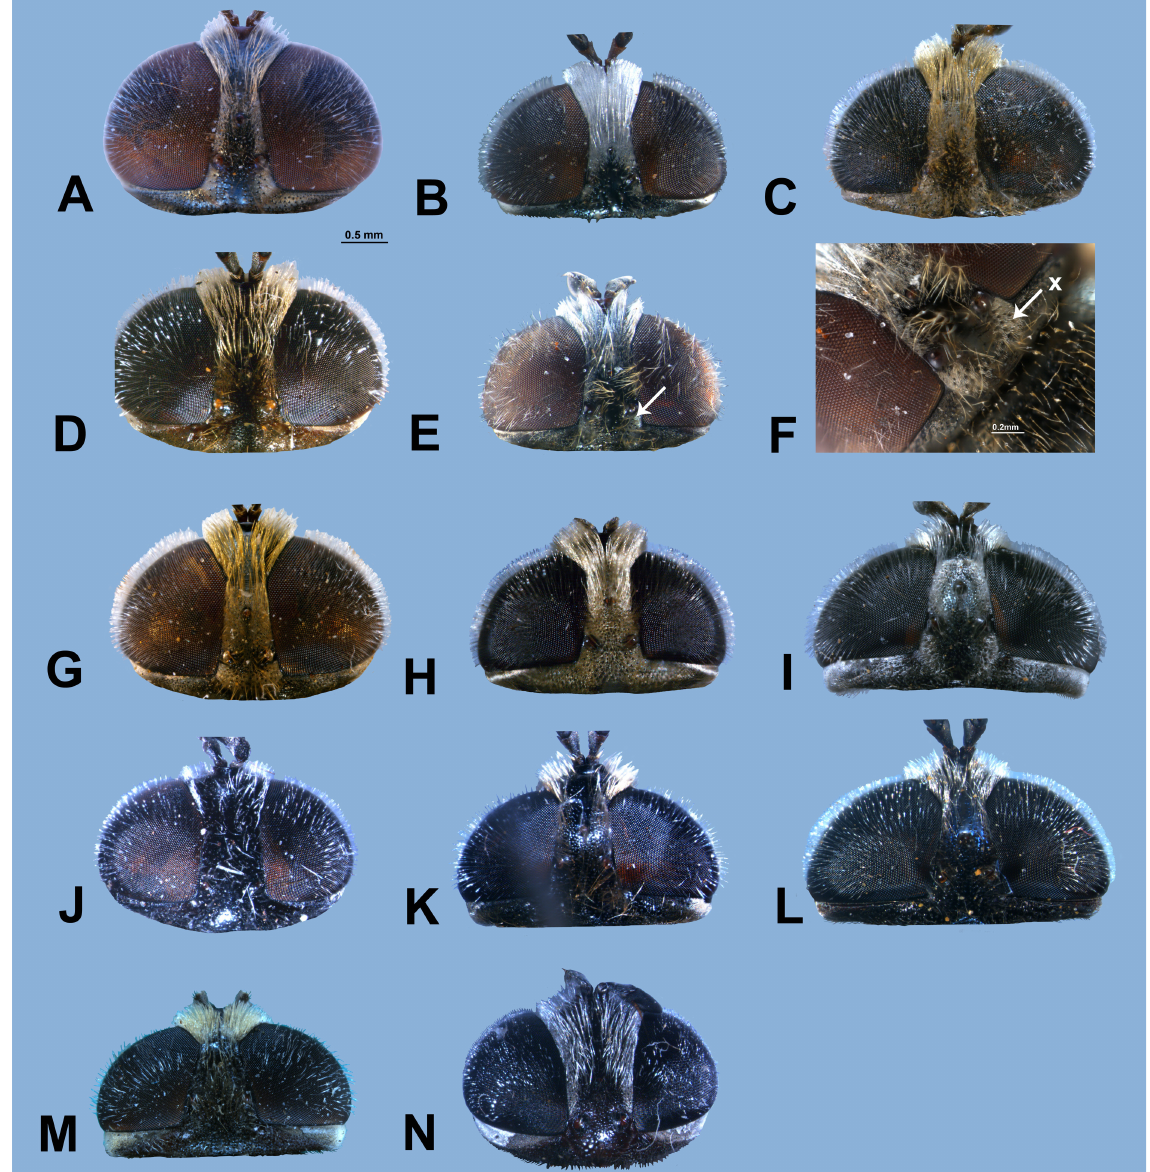
Fig. 2. Megatrigon spp., head, dorsal view. A . Megatrigon argenteus (Walker, 1852) comb. nov. (♂). B . M. argentifrons sp. nov. (♂). C . M. argentimaculatus sp. nov. (♂). D . M. magnicornis sp. nov. (♂). E – F . M. natalensis sp. nov. (arrow = postocellar spot) (♂). G . M. sexmaculatus sp. nov. (♂). H . M. apiformis sp. nov. (♂). I . M. cooksoni sp. nov. (♂). J . M. immaculatus sp. nov. (♂). K . M. ochreatus (Hull, 1964) comb. nov. (♂). L . M. tabanoides sp. nov. (♂). M . M. jacobi (Hervé-Bazin, 1913) comb. nov. (♂). N . M. nivalis (Hull, 1964) comb. nov. (♀). Symbol: x = postocellar